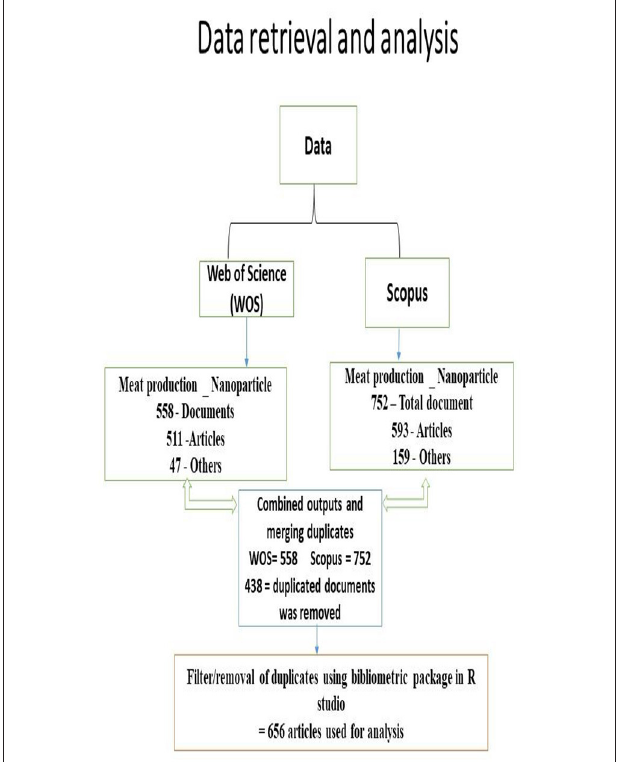
FIGURE 1 | Schematic presentation showing the inclusion and exclusion criteria for outputs